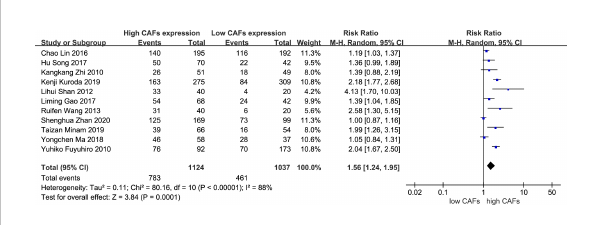
FIGURE 4 High expression of CAFs is associated with serosal in fi ltration in gastric cancer. CAF, cancer-associated fi broblast; CI, con fi dence interval.